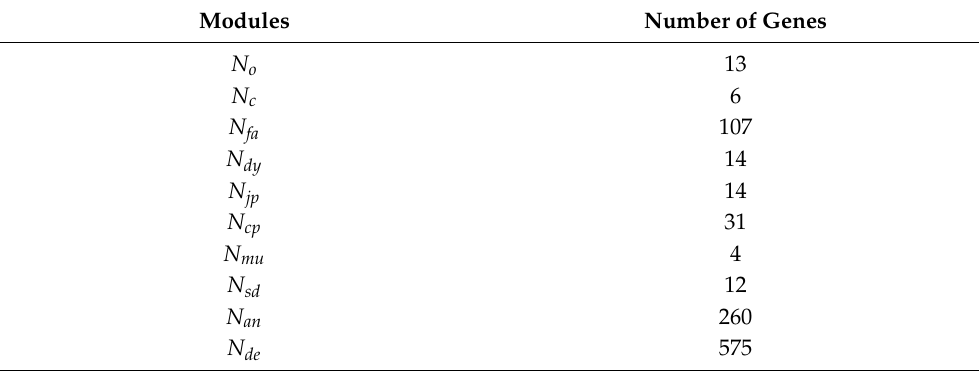
Table 1. Number of genes of each module.